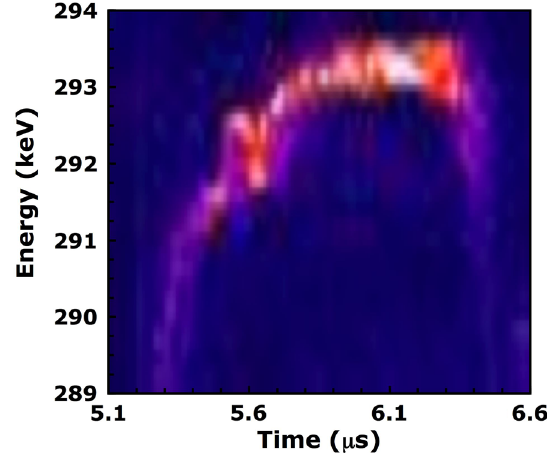
FIG. 8. Longitudinal phase space distribution of the NDCX beam with a 2 (cid:1) s pulse measured with two